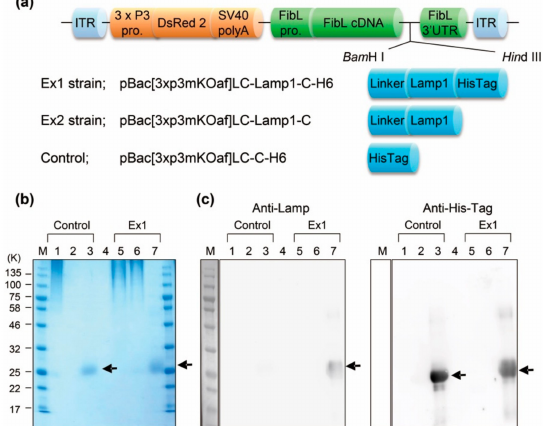
Figure 1. Breeding of the transgenic silkworm. ( a ) Construction of the expression vector. Each plasmid contains expression units for selection marker gene ( DsRed2 ) and cDNA of fibroin L-chain ( FibL cDNA) between the piggyBac inverted terminal repeat (ITR). Three gene fragments containing Lamp1 or His Tag were inserted into the 3’ ends of FibL cDNA using restriction site of Bam H I and Hin d III. 3xP3 pro., 3xP3 promoter; SV40 polyA, polyA signal of SV40; FibLpro., promoter of fibroin L-chain; and FibL 3’ UTR, 3’ untranslated region of fibroin L-chain. ( b ) SDS-PAGE analysis of purified FibL-Lamp1-His protein from Ex1 strain and the control strain. ( c ) Western blotting analysis using Lamp1, and His-tag antibody. Each arrow indicates the expected molecular weight of the target protein. Lane 1, FibL sample before purification; Lane 2, flow-through of FibL column; Lane 3, purified FibL; Lane 4, bu ff er; Lane 5, FibL-Lamp1 sample before purification; Lane 6, flow-through of FibL-Lamp1 column; and Lane 7, purified